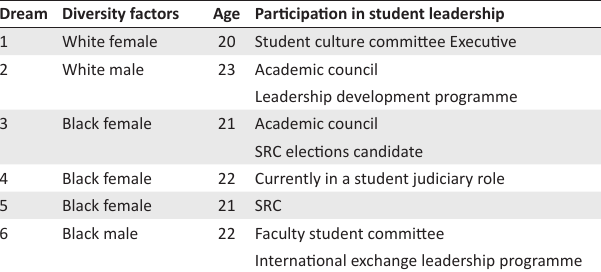
TABLE 1: Description of the group